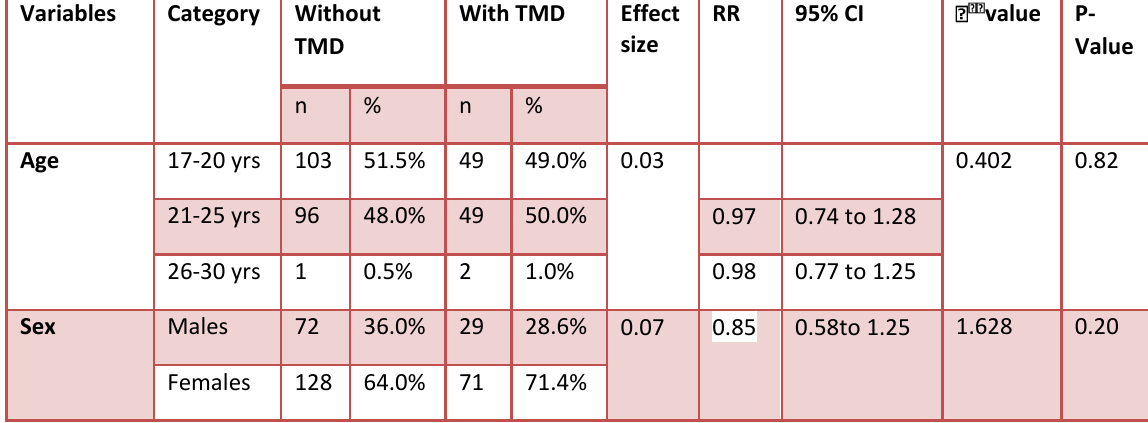
Table 4- Age and gender wise comparison of prevalence of TMD among study participants using Chi Square TestManagement, Commerce & Finance students)severity